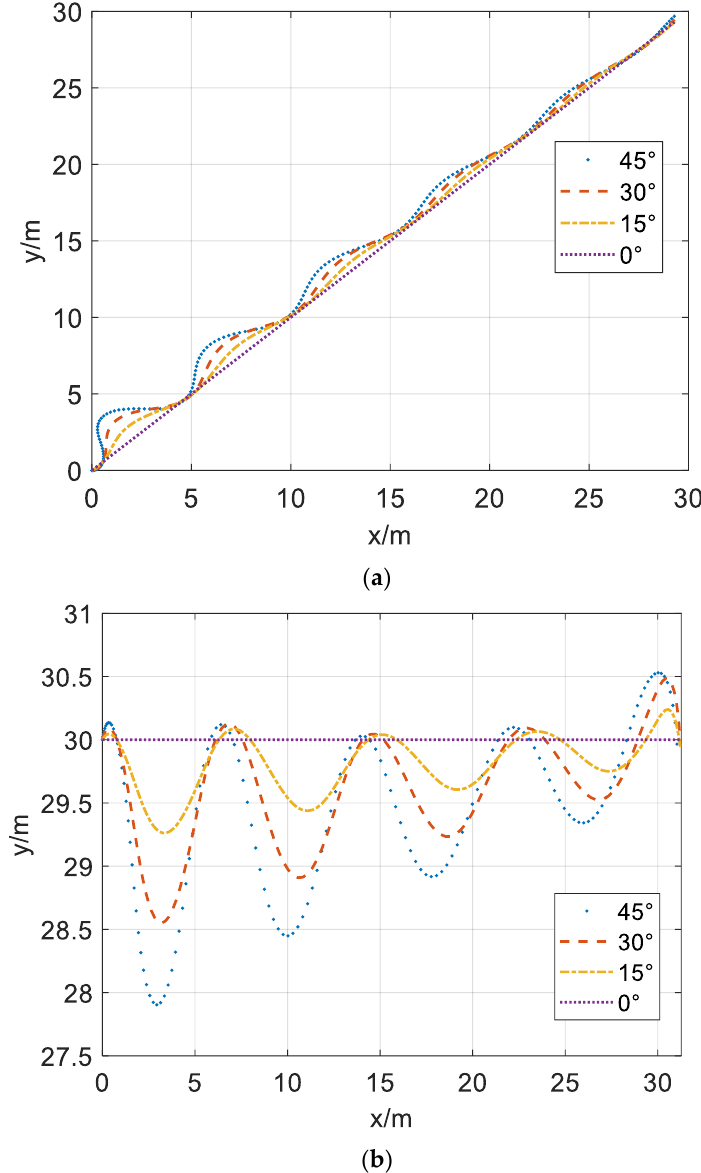
Figure 17. The trajectory diagrams with two paths:( a ) from (0,0) to (30,30),( b )from (0,30) to (30,30).